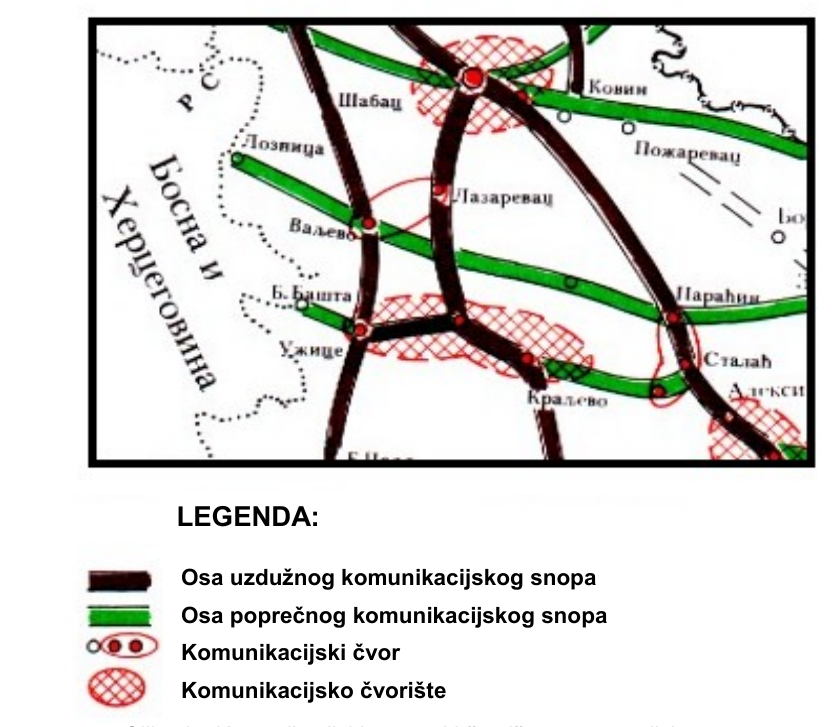
Figure 1 – Communication beams and nodes on the strategic